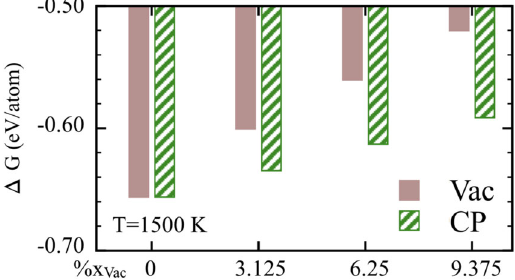
Fig. 8 Vacancy phase stability during breakaway oxidation of Ti 2 AlC. Calculated Δ G form of Al-depleted Ti 2 [Al 1 – x Va x ]C, i.e., with vacancy, relative to the competing phases (CP) (Ti 2 AlC, Ti 3 AlC, and Ti 3 AlC 2 ) at 1500 K shows that Ti 2 (Al 1 – x Va x )C is energetically less stable. The con fi gurational entropy term is included for vacancy cases using Δ S con fi g = − [( x vac ln x vac + (1 − x vac ) ln(1 − x vac ))], here x vac = (0.03125; 0.0625;